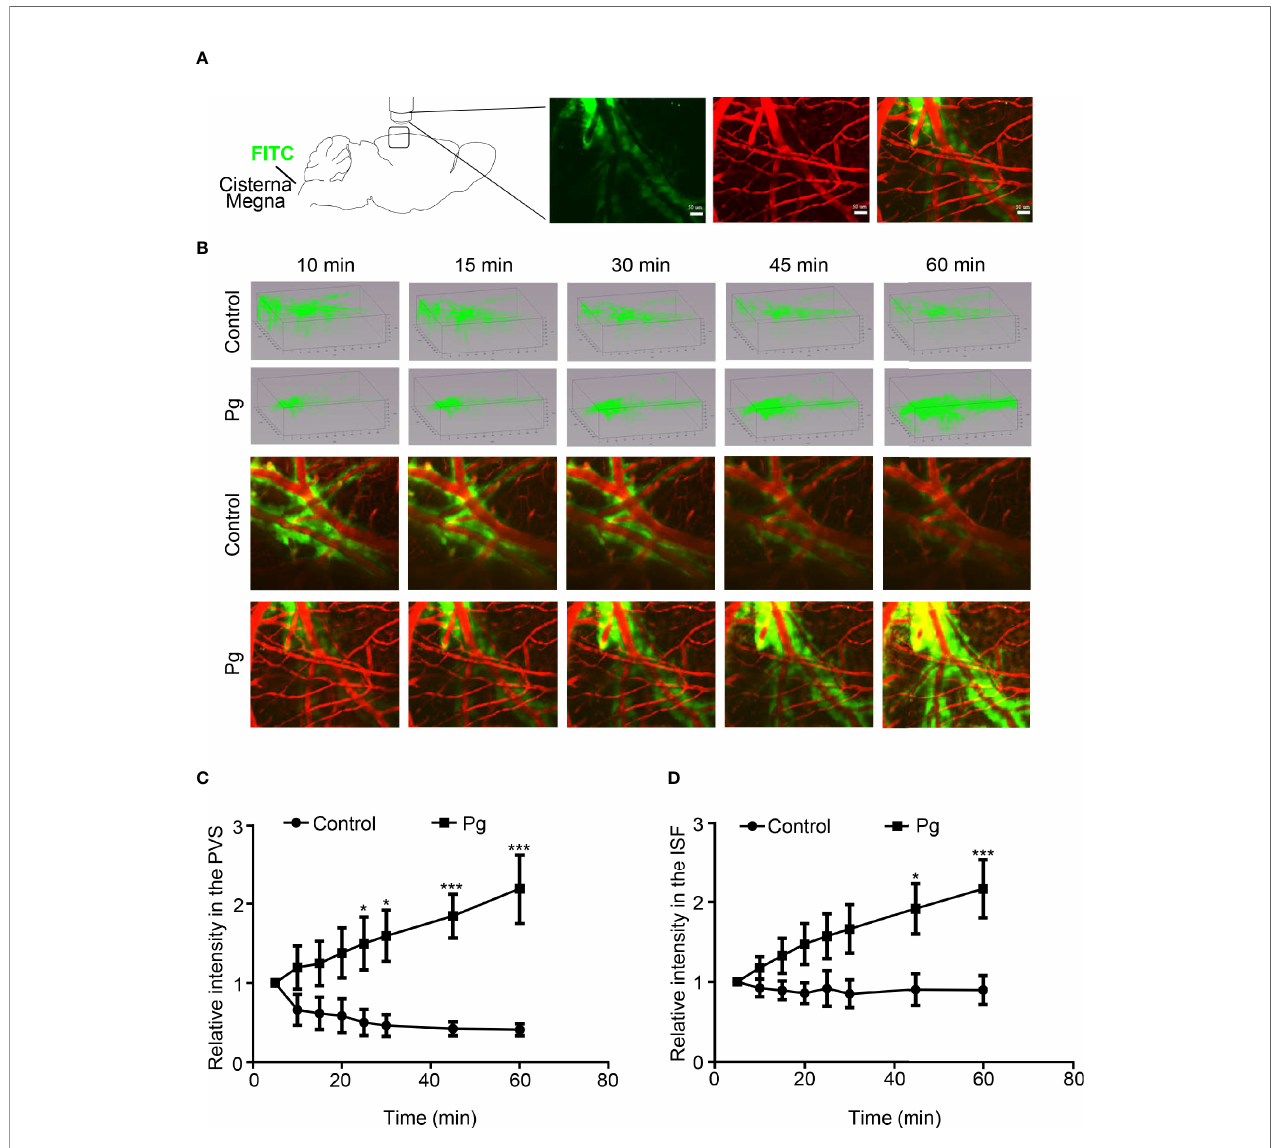
FIGURE 4 | Clearance function of the glymphatic system, including in fl ow of the cerebrospinal fl uid (CSF) through PVS – ISF exchange and the out fl ow of ISF drainage. (A) Diagram representing the two-photon microscopic image of the CSF tracer into the cisterna magna. (B) Three-dimensional images of the distribution of the CSF tracer in the Pg and control groups. Representative picture of the CSF tracer entering the brain parenchyma along the PVS. (C) Comparison of the relative fl uorescence intensity in the PVS. (D) Comparison of the relative fl uorescence intensity in the ISF between the control and Pg group. n = 4, data were shown as means ± SEM, * p ≤ 0.05; *** p ≤ 0.001. Scale bar, 50 m